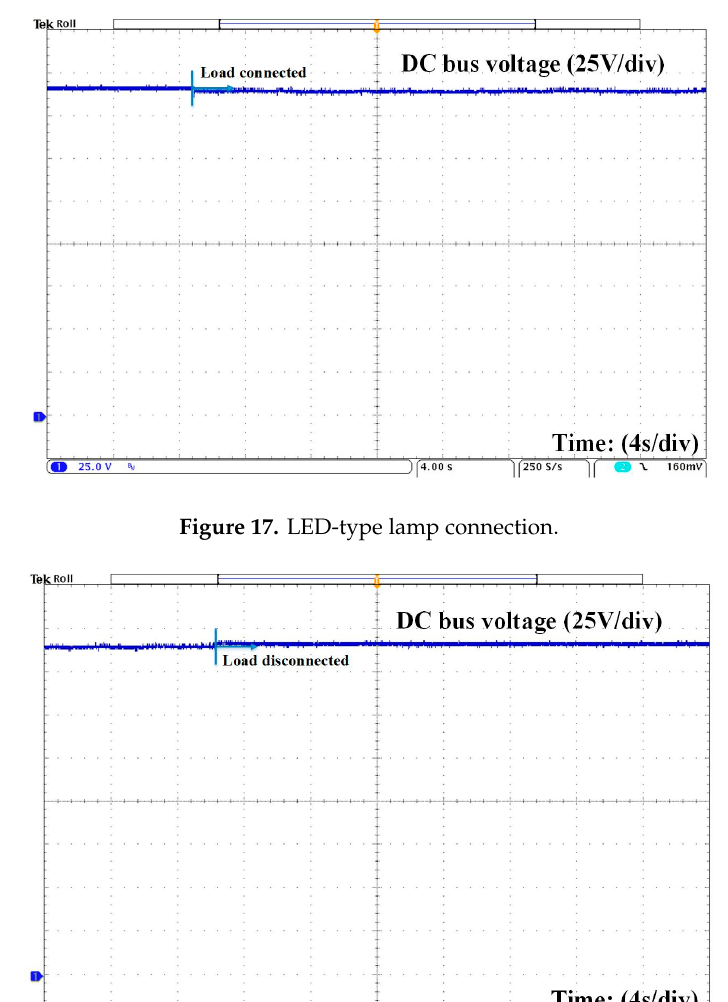
Figure 18. Disconnection of LED-type lamp.